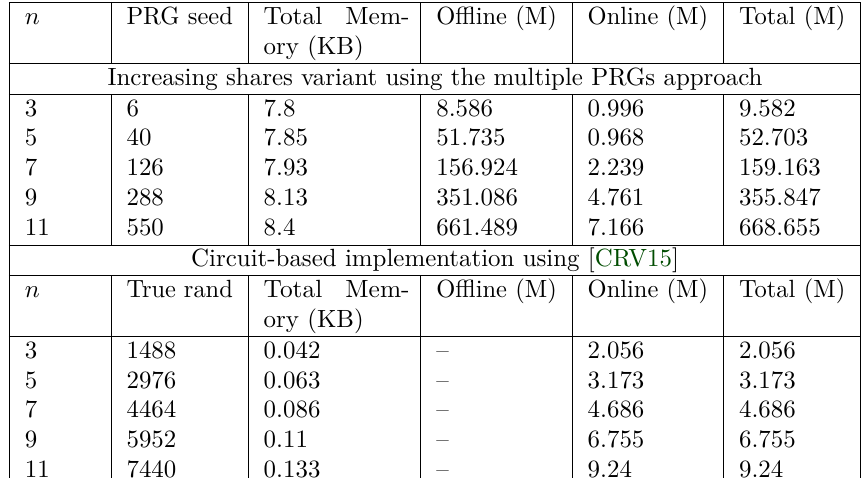
Table 8: Higher-order masked S-box computation using our variant of the table-based scheme with full pre-processing (Algorithm 4) using the multiple PRG technique for increasing shares variant (Algorithm 8) and the circuit-based implementation of PRESENT using [CRV15]. The first entry represents the number of input shares. The true random PRG seed and the total memory required for PRESENT are given in bytes and KB, respectively. The offline, online and total execution are represented in millions of clock